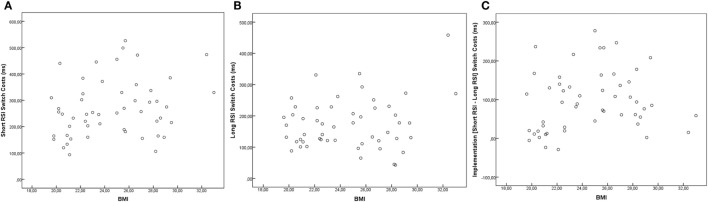
Mean switch costs in milliseconds as a function of body mass index (BMI). (A) Switch costs calculated as the reaction time (RT) difference between alternation and repetition trials in the short response-stimulus interval (RSI) (150 ms) condition. (B) Switch costs calculated as the RT difference between alternation and repetition trials in the long RSI (1,200 ms) condition. (C) Switch costs calculated as the difference between the short RSI and long RSI conditions reflecting implementation or preparatory costs only due to a time constraint.